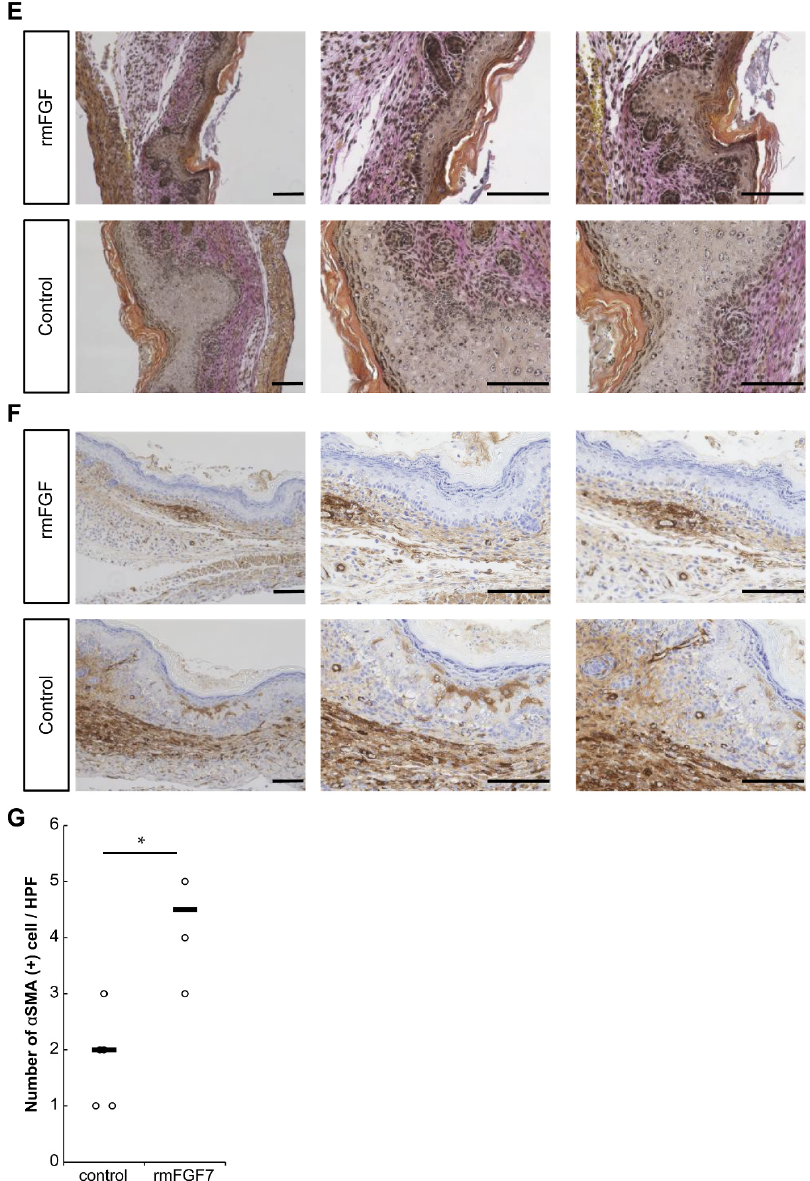
Figure 4. Effect of rmFGF7 administration on wound healing in mouse fetuses. ( A ) Macrograph of a scar; bar = 1 mm. ( B ) Comparison of the wound area. ( C ) Hematoxylin-eosin staining of wounds; bar = 100 µm. ( D ) Masson trichrome staining of the wound. Bar = 100 µm. ( E ) Elastica van Gieson staining of the wound; bar = 100 µm. ( F ) Immunostaining of the wound for α SMA; bar = 100 µm. ( G ) Counting of α SMA-positive cells. *, p < 0.05. HPF, high power field; FGF7, fibroblast growth factor 7; α SMA, alpha-smooth muscle actin.